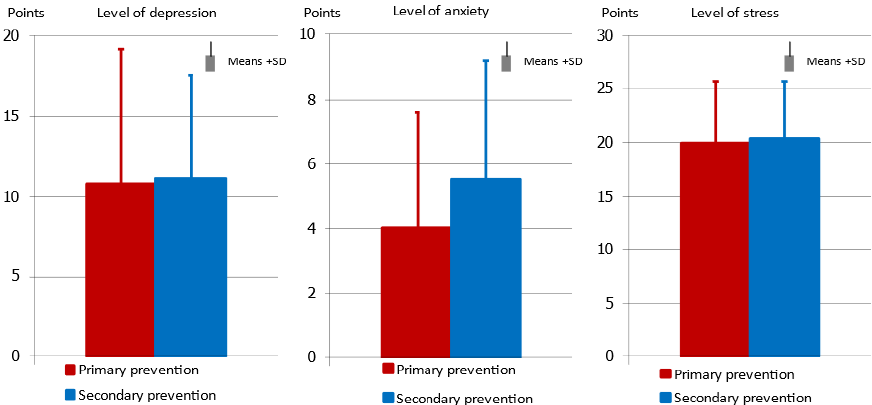
Figure 2. Level of depression measured by Beck’s Depression Inventory, level of anxiety measured by analogue scale, and level of stress measured by Perceived Stress Scale (PSS-10), according to type of prevention.